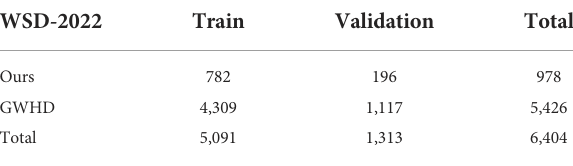
TABLE 1 Number of images in the WSD-2022 dataset.